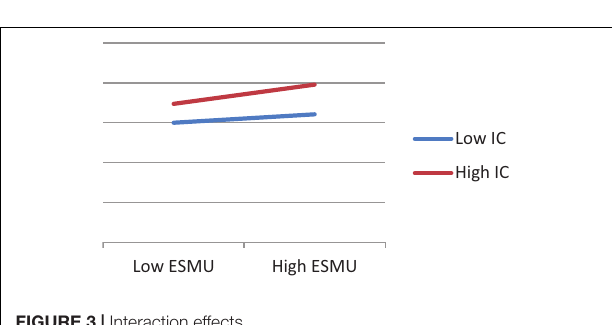
FIGURE 3 | Interaction